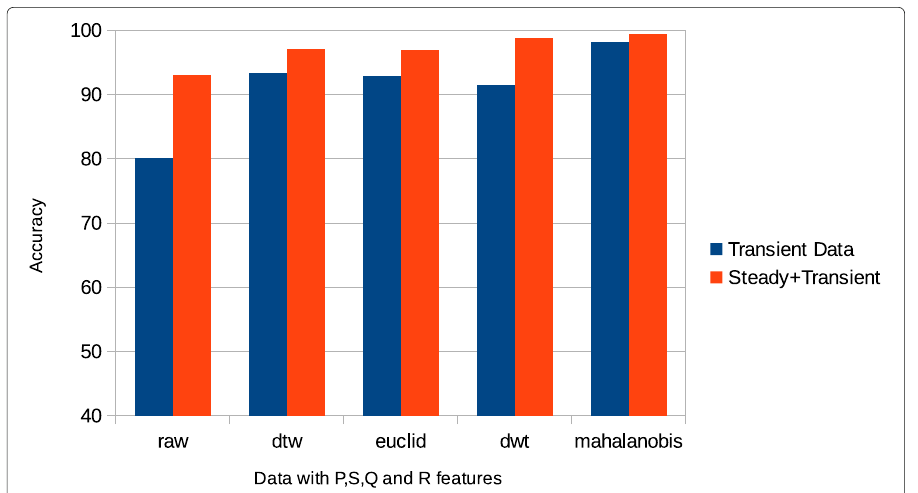
Fig. 9 Performance of steady+transient feature fusion based RF classifier with transient feature based RF classifier with P,S,Q and R